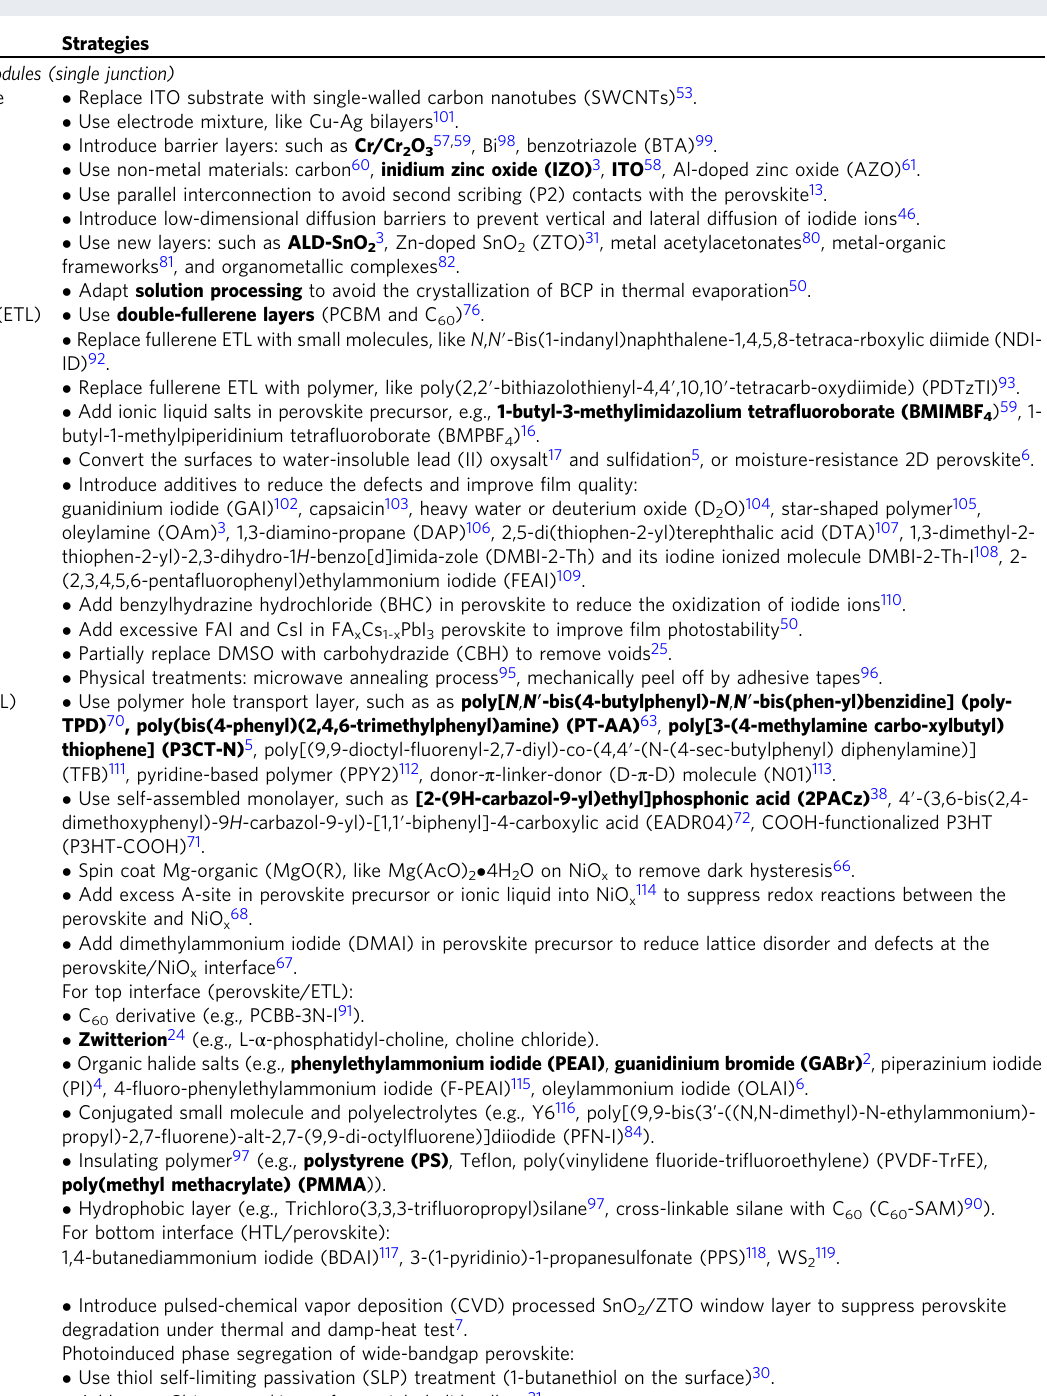
Table 2 The summary of instability origins and corresponding strategies to improve the stability of IPSCs (based on rigid substrates).